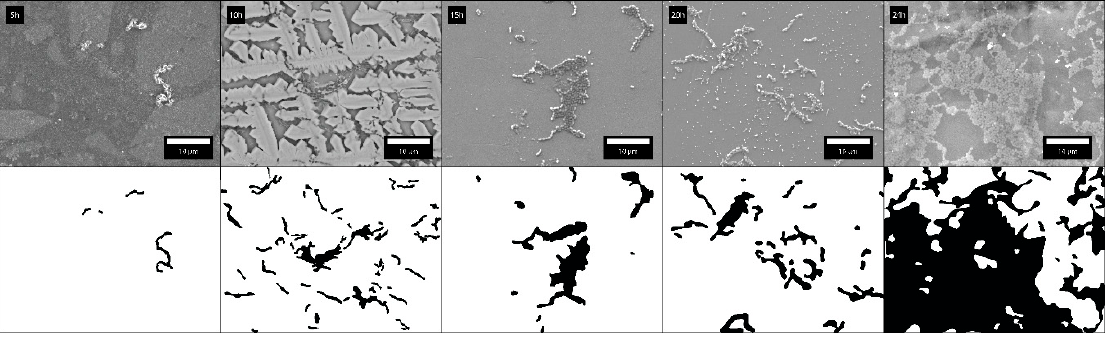
Figure 7. Time evolution of adhered bacteria on Chromasit (5, 10, 15, 20, and 24 h).